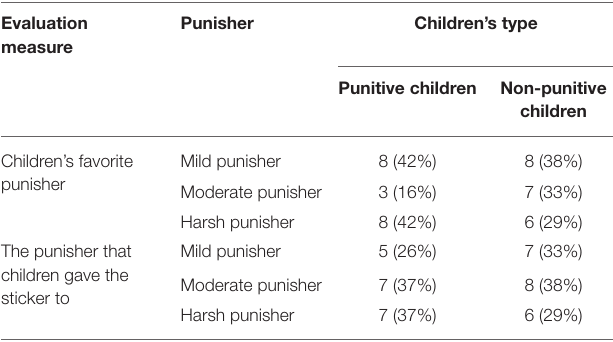
TABLE 4 | The number (proportion) of two types of children’s favorite punisher and of children who gave stickers to each punisher in experiment 4. Evaluation measure